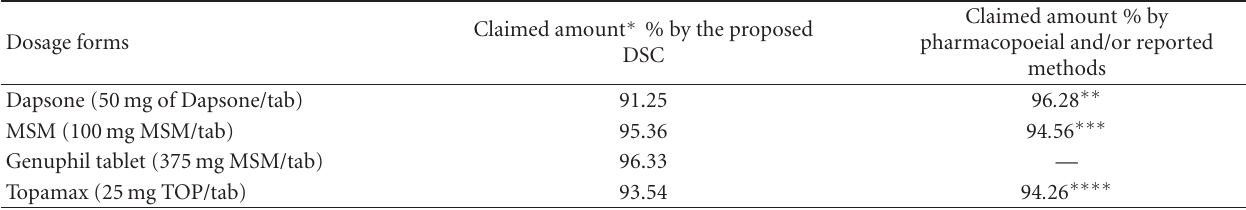
Mean of five instrumental run. ∗∗ O ffi cial BP